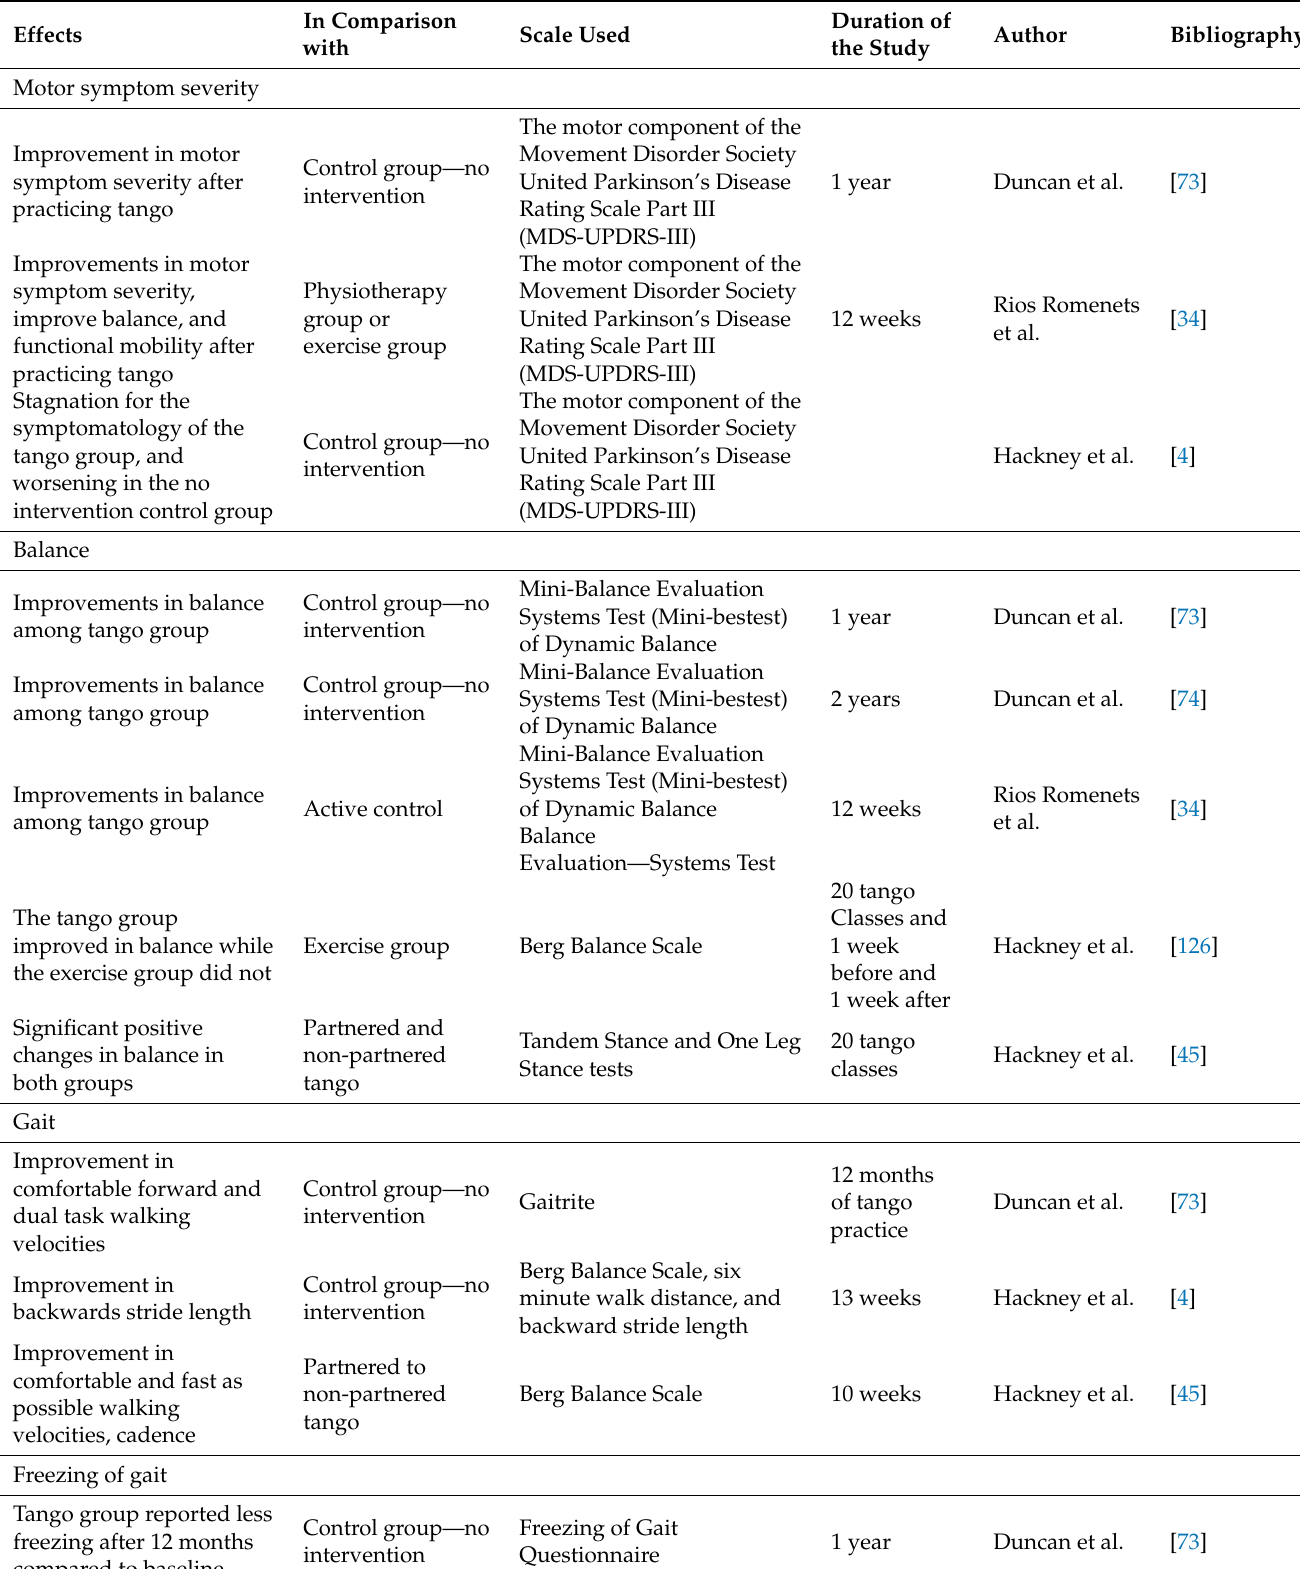
Table 1. Representative studies for the beneficial evolution of both motor and non-motor features of Parkinson’s disease after tango